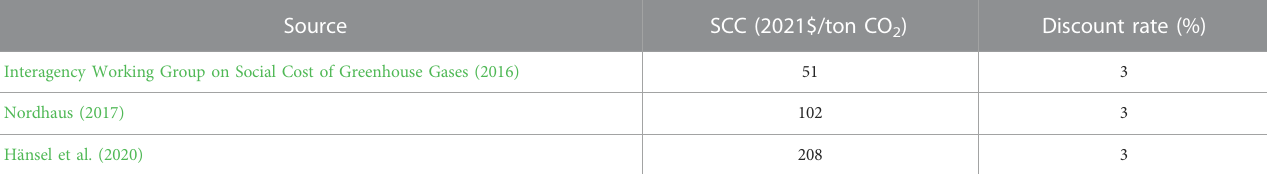
TABLE 2 FEWSVT social cost of carbon (SCC) estimates.